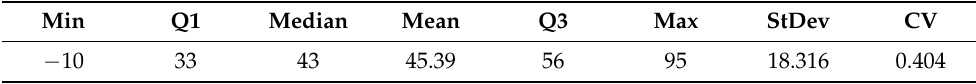
Table 7. Extended 5-Number Summary of